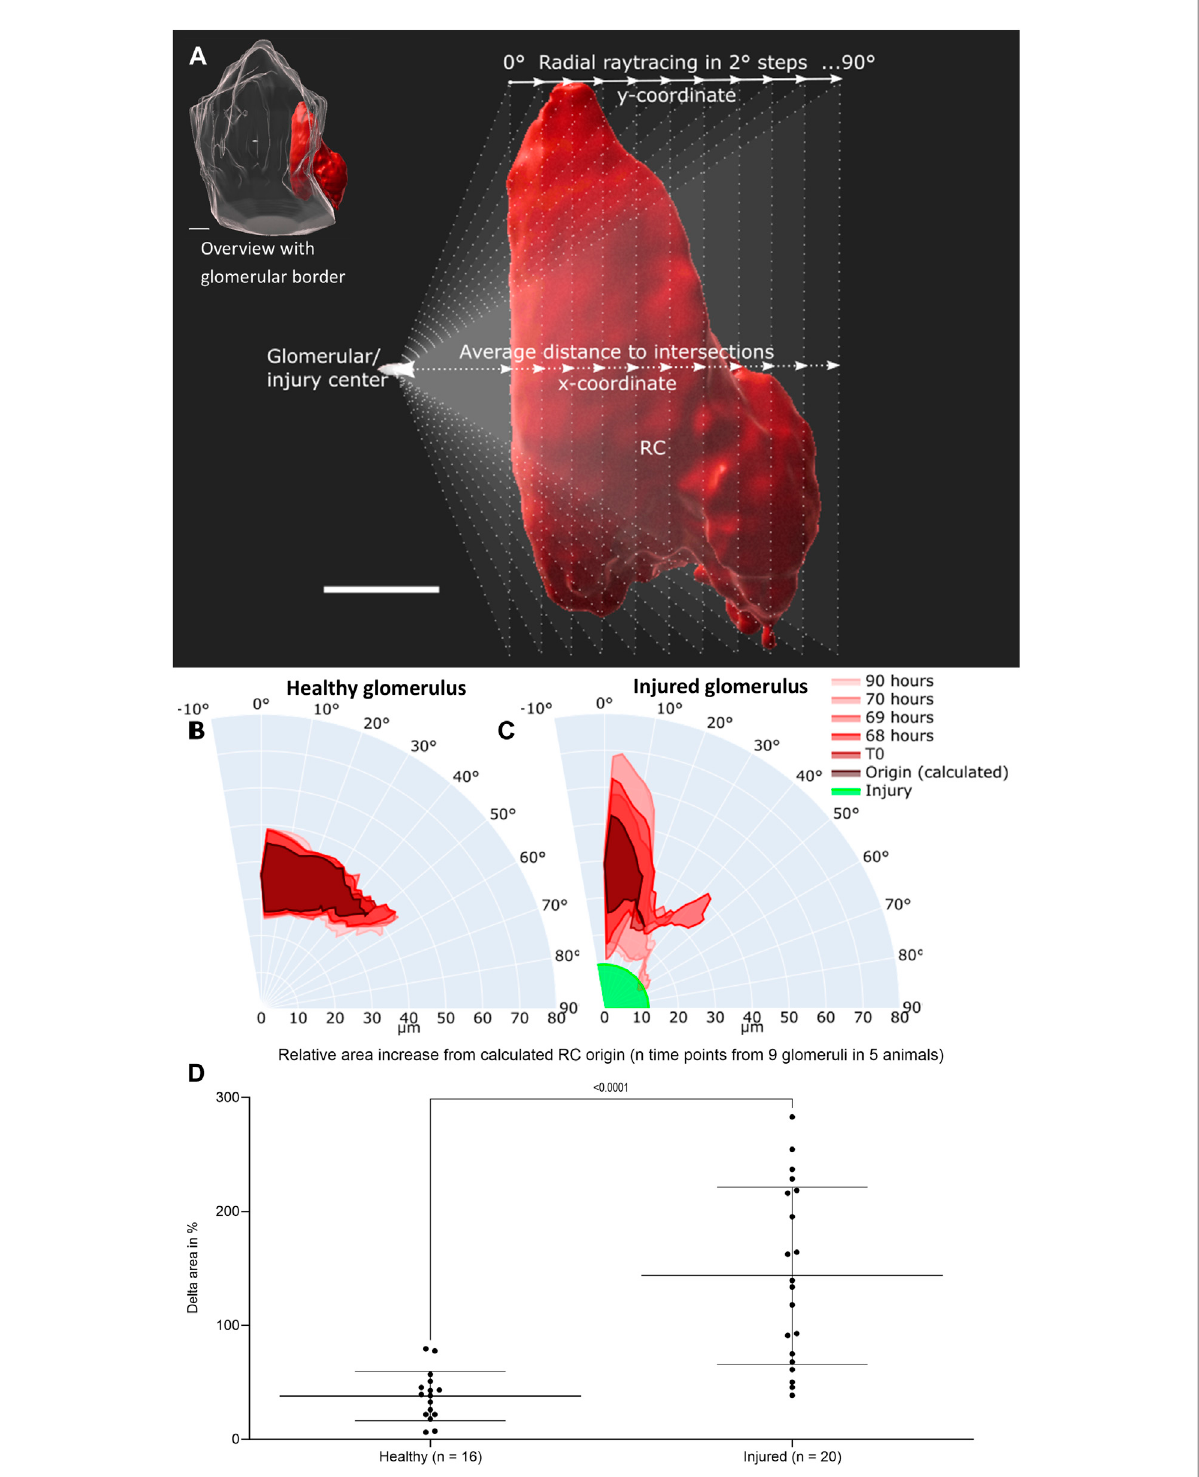
FIGURE 4 Intravitaldata(representativehealthyandinjuredglomeruli)wasquanti fi edviaaveragedistanceoverviewanglesin2-degreestepsbasedonray tracing. (A) Schematicrepresentationoffan-likeobjectquanti fi cationforhealthyandinjuredglomeruli.White scalebarsrepresent 10 µm.Theorigin of raytracing RC under physiological conditions were set to the center of the glomerular object and under pathophysiological conditions to the center of the auto fl uorescent laser injury. Resulting healthy RC motion and migration after injury are pictured in polar charts. (B) Quanti fi cation